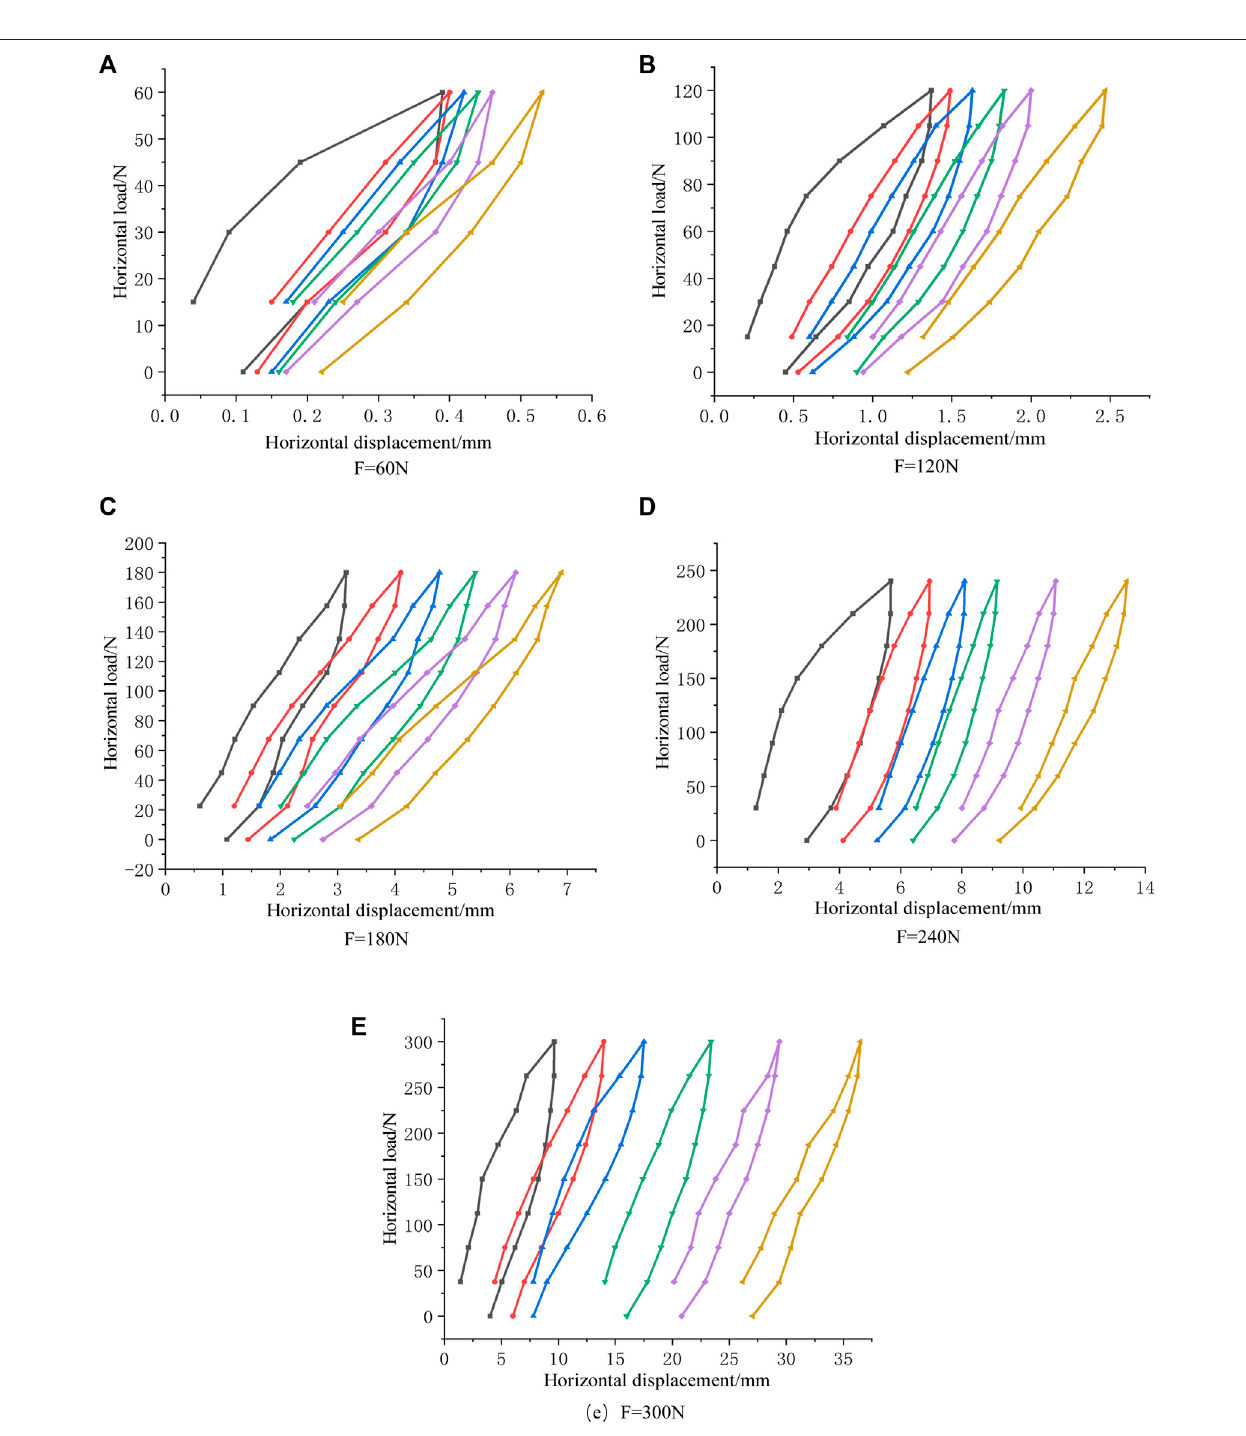
FIGURE 14| Horizontal displacement curve ofcompositefoundation under horizontalcyclic load. (A) Horizontal displacement curve when F = 60N. (B) Horizontal displacement curvewhen F = 120N. (C) Horizontal displacement curve when F = 180N. (D) Horizontal displacement curve when F =240N. (E) Horizontal displacement curve when F =